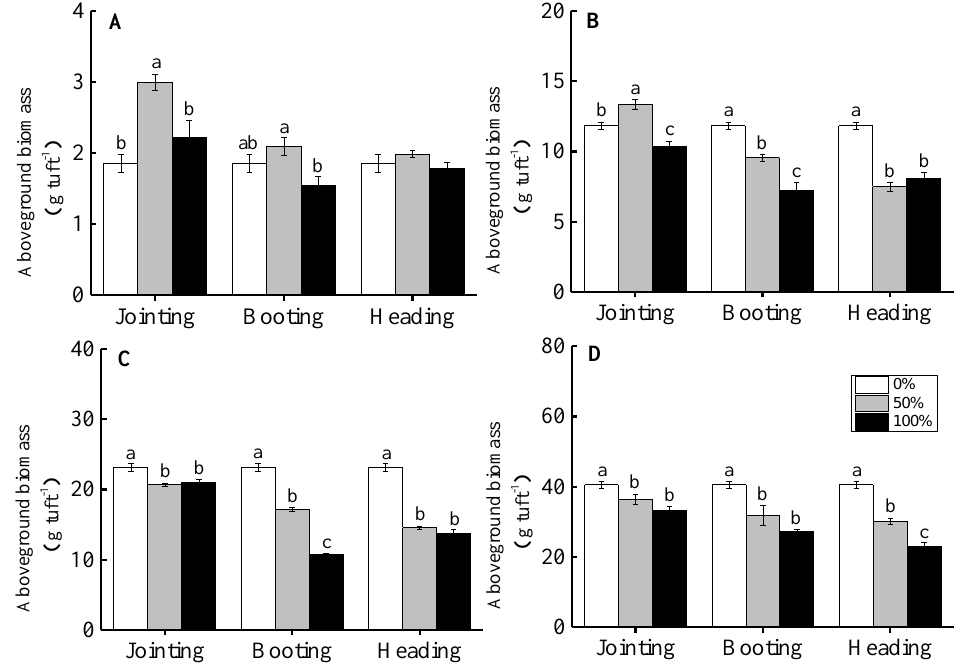
Figure 5. The e ff ect of clipping intensity on the aboveground biomass of H. brevisubulatum at di ff erent grades when clipping at the jointing, booting, and heading periods. A , B , C , and D represent the Figure 5. The effect of clipping intensity on the aboveground biomass of H. brevisubulatum at different grades (1, 2, 3, and 4, respectively) of the tuft diameters of H. brevisubulatum . Di ff erent lowercase letters grades when clipping at the jointing, booting, and heading periods. represent significant di ff erences among di ff erent clipping intensities ( p <